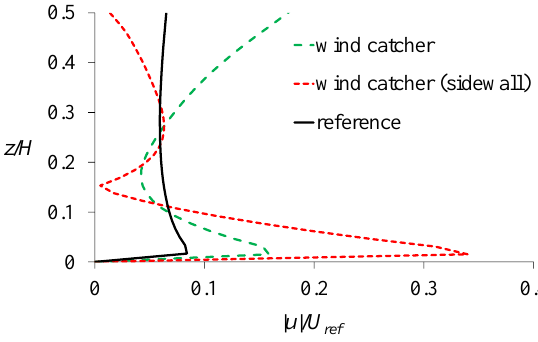
Figure 18. Comparison of normalized stream-wise velocity magnitude at the middle of canyon